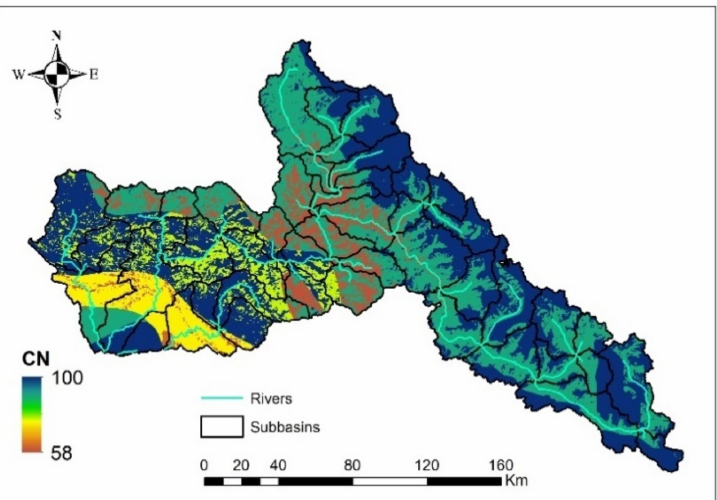
Figure 9. CN map of the Chenab river catchment.